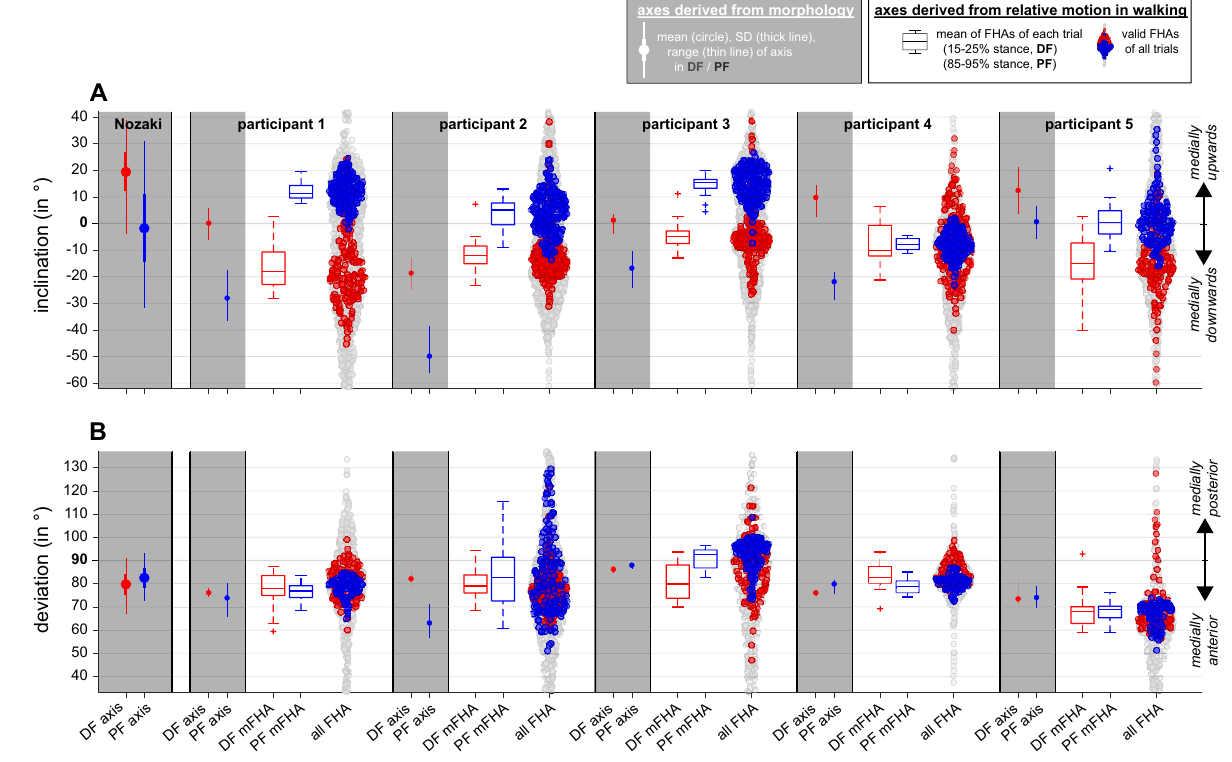
Figure 3. ( A ) Inclination and ( B ) deviation of representative ankle joint axes (for definition of inclination and deviation, see also Fig. 2) derived from morphology (grey background) and from walking trials (white background) for dorsiflexion (DF, red) and plantarflexion (PF, blue). Next to the participants 1 to 5, axes orientations derived from morphology reported by Nozaki et al. 3 are presented. Boxplots represent mean of finite helical axes (mFHAs) of each walking trial either in dorsi- or plantarflexion. Swarm plots represent orientations of all FHAs with a rotation greater than 2° for the entire stance phase (grey), overlaid by those during DF (red) and by those during PF